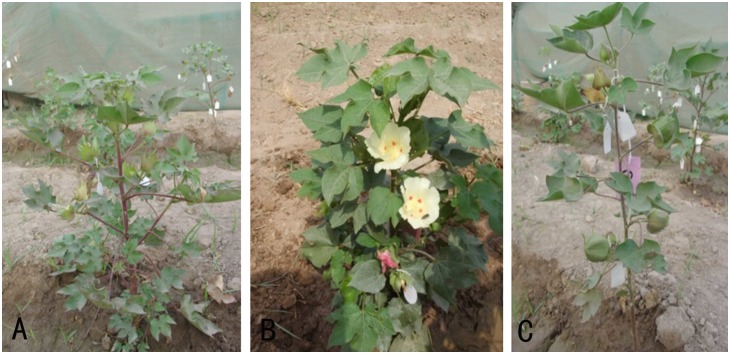
Hybrid Progenies of [2(G. arboreum)×G. hirsutum].A = BC1; B = BC2; C = BC3.